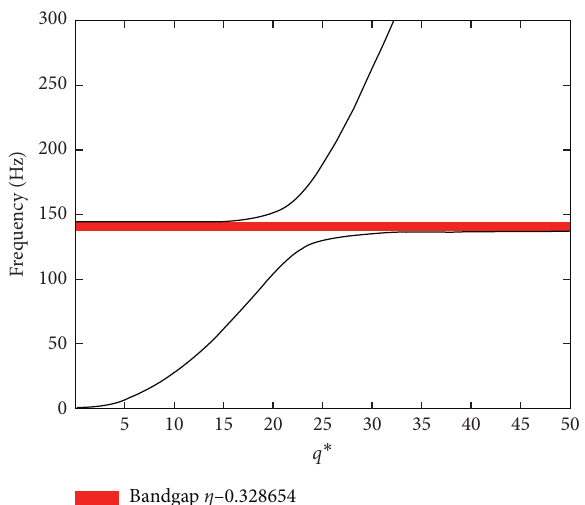
Figure 9: The locally resonant band structures of the metamaterial beam in pure inductance circuit with η � 0.328654.